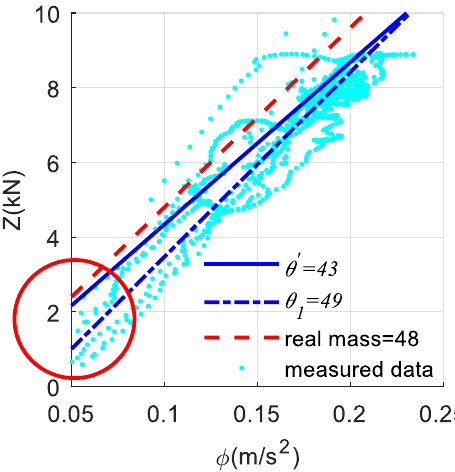
Figure 10. Total valid input and output of the offline estimation in one independent test (full load 2).